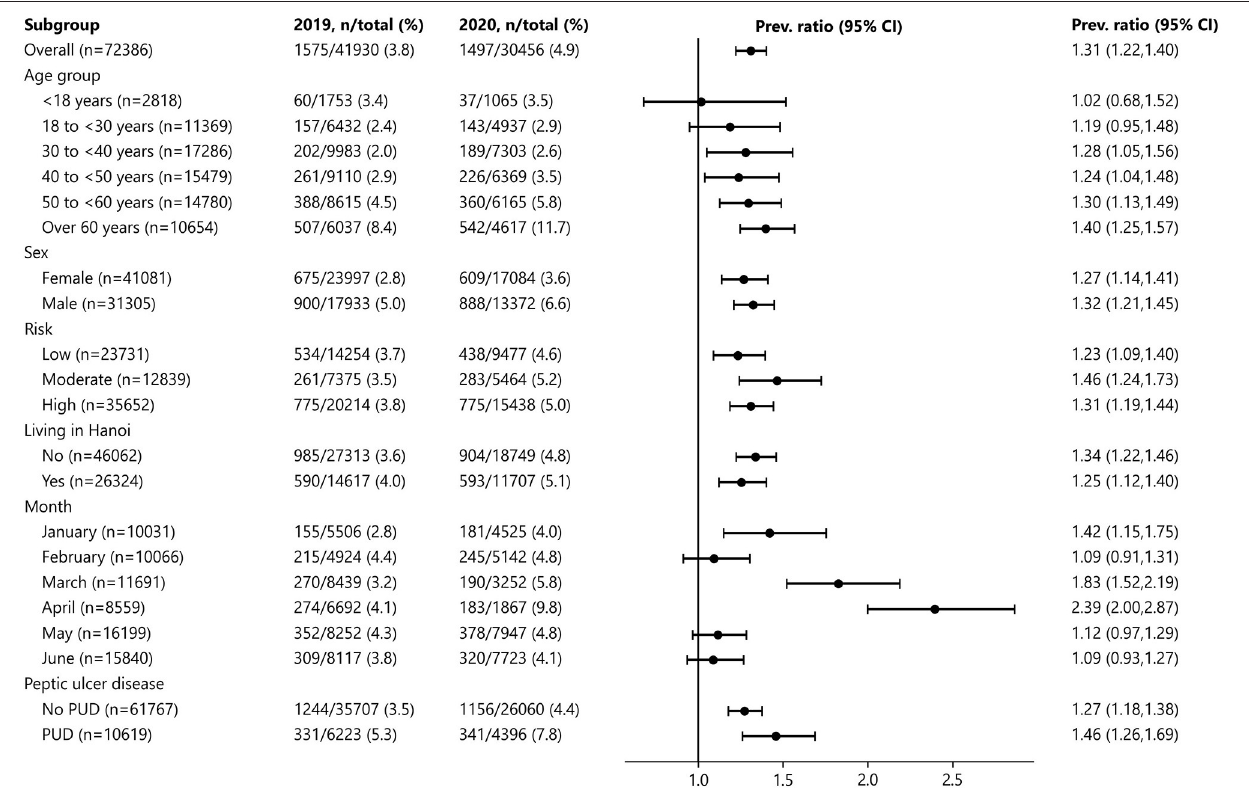
FIGURE 2 | Stratified comparison of the proportion of GI emergency endoscopy between 2019 and 2020.